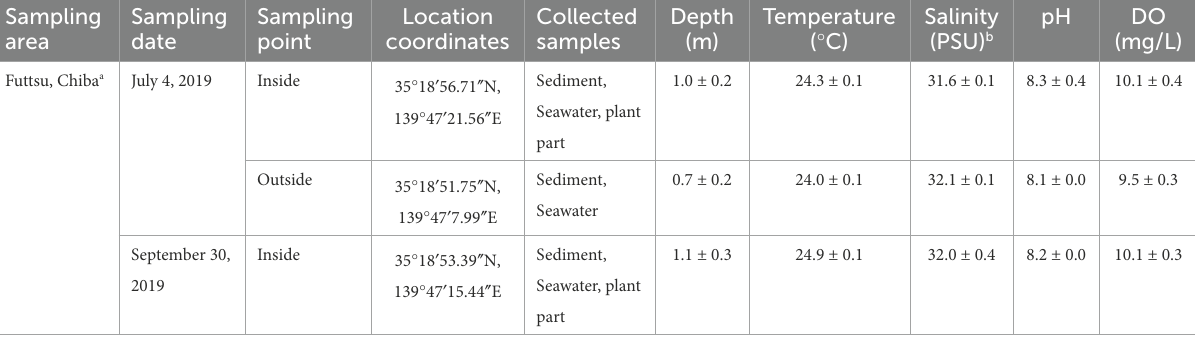
TABLE 1 Location of sampling points and environmental variables of the seawater at each sampling date. Sampling